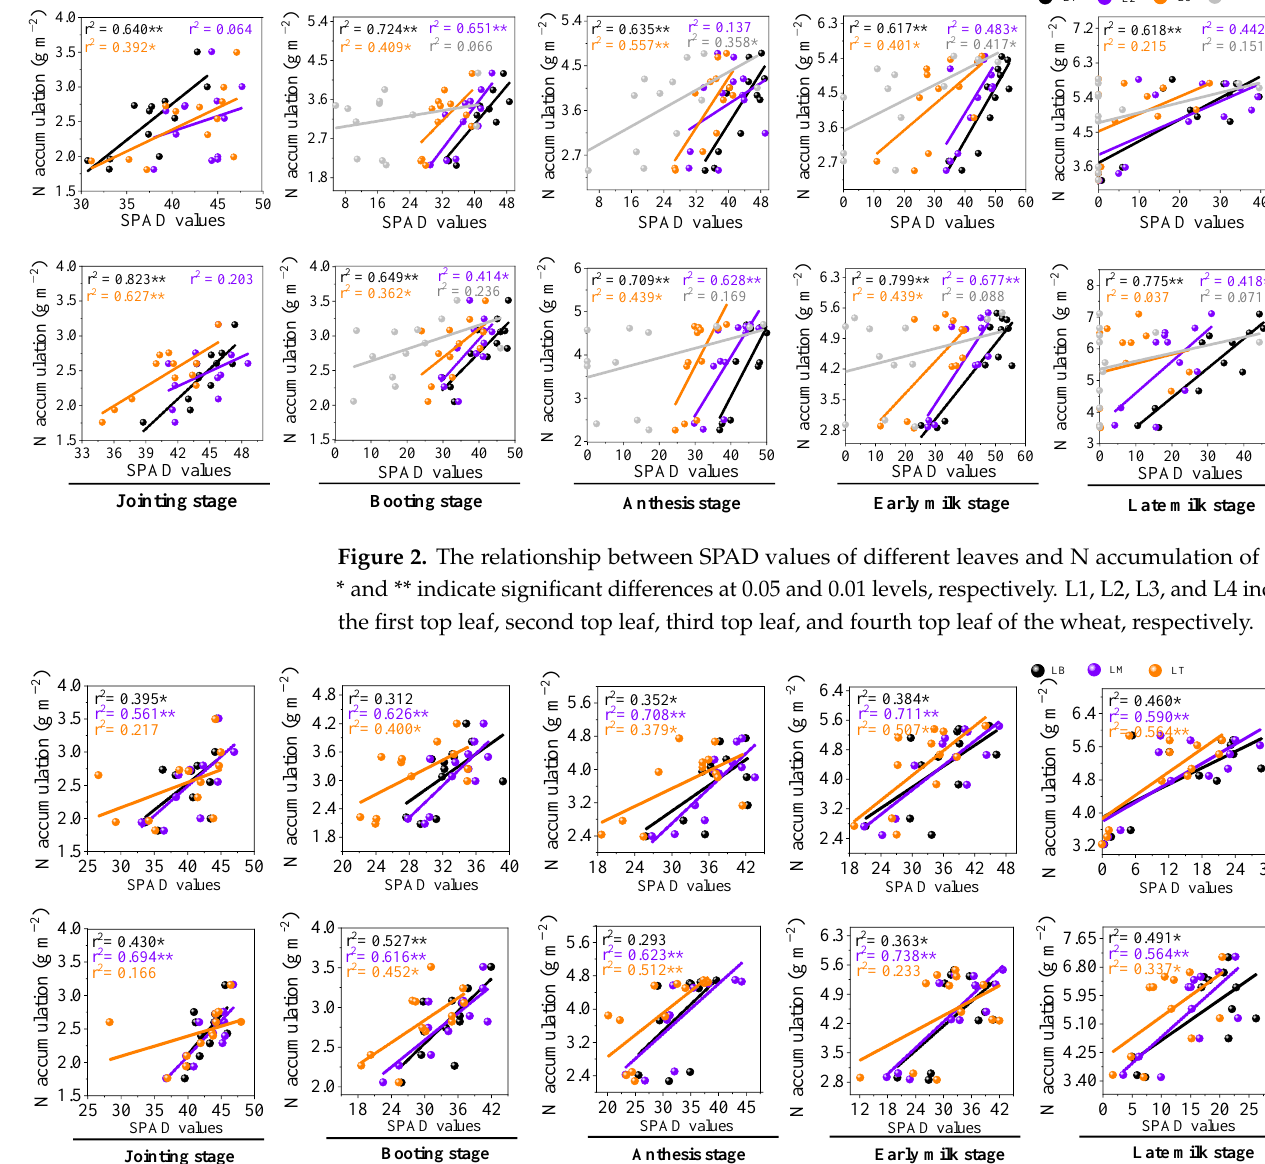
Figure 3. The relationship between SPAD values and N accumulation in different leaf positions [leaf base (LB), leaf middle (LM), and leaf tip (LT)] in wheat. * and ** indicate significant differences at 0.05 and 0.01 levels, respectively. LB, LM, and LT indicate the leaf base (30% distance from the leaf base), leaf middle (30–60% distance from the leaf base), and leaf tip (more than 60% distance from the leaf base) of wheat, respectively. LB, LM and LT are represented by black, purple and yellow